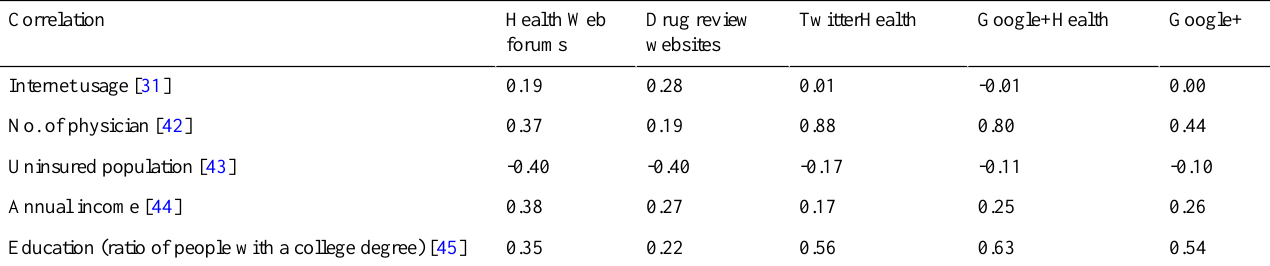
Table 6. Correlation across all states between the normalized (per capita) number of users for each type of health-related social outlets, and each state’s population, normalized number of Internet users, normalized number of physicians, normalized number of uninsured patients, average annual income, and percentage of population with college degree or